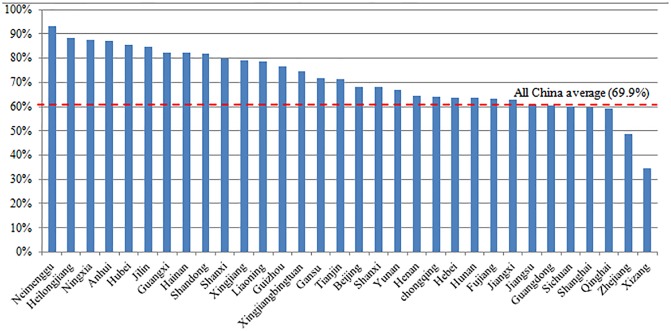
Percentage of migrant children in 32 host provinces.